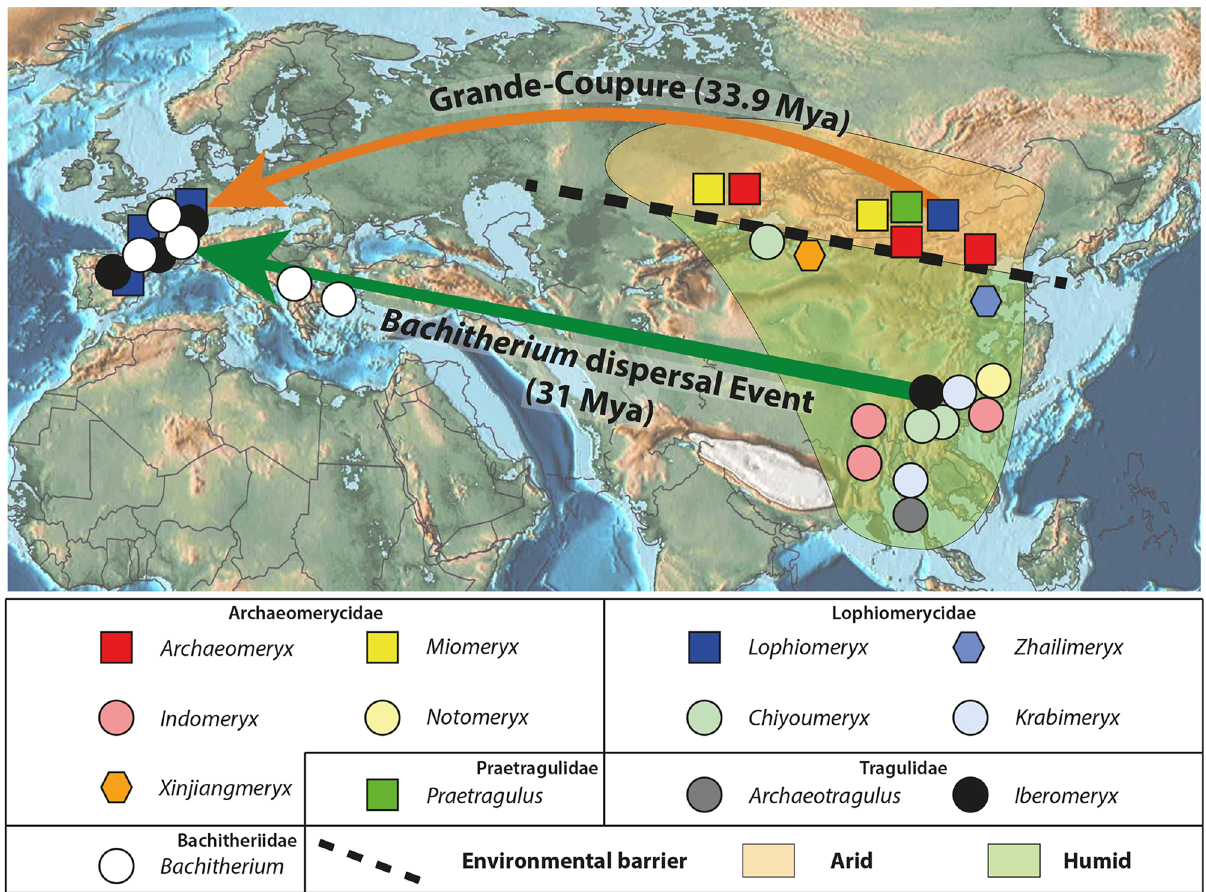
Figure 2. Paleobiogeography of the Eurasiatic ruminants during the Eocene at the genus level. The localities are from the synthesis of data 2,17,18,22,49 . The palinspastic map is modified from Scotese 52